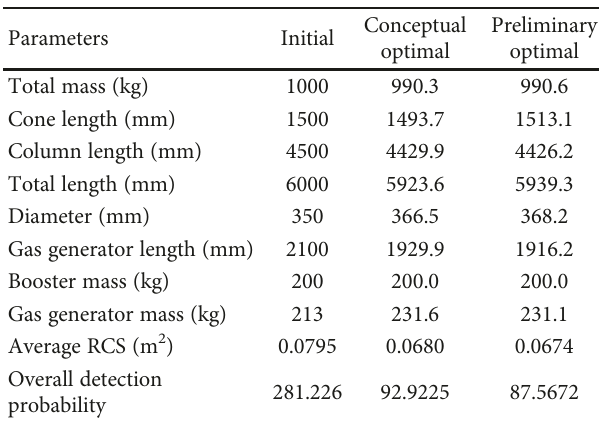
Table 9: Output parameters.